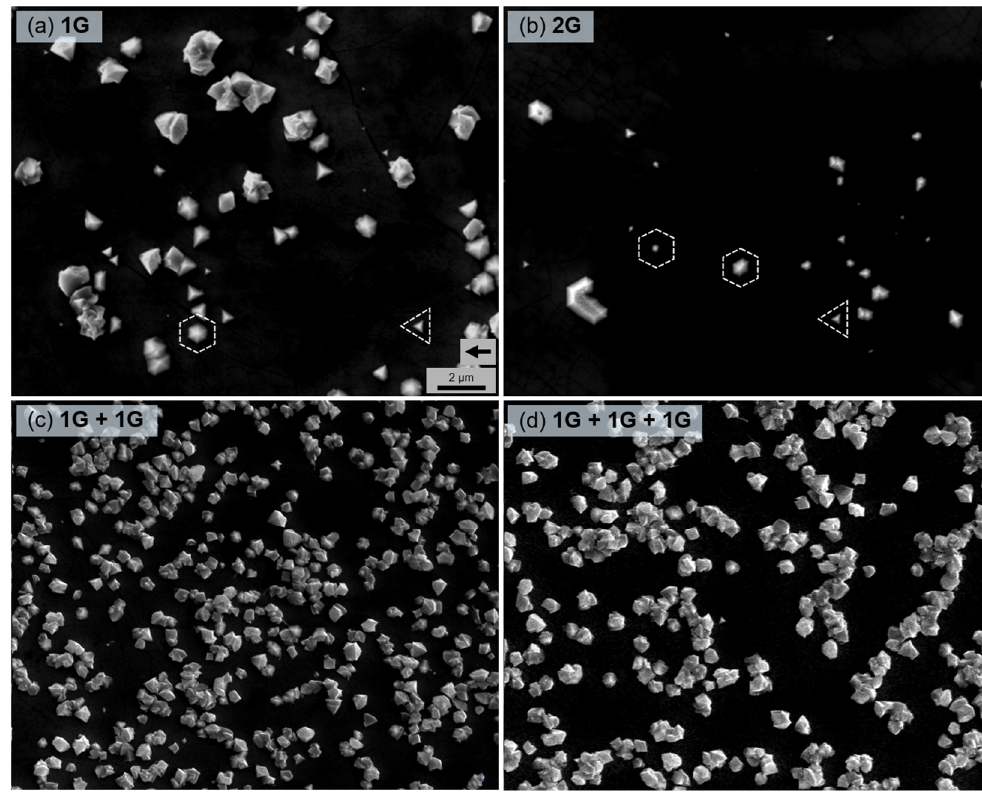
Figure 3. SEM images of the GaN nuclei after the growth of the low-temperature nucleation layer for 5 min on monolayer graphene ( a ), bilayer graphene ( b ), double-stack graphene ( c ), and triple-stack graphene ( d ). Scale bar in ( a ) is the same for all images. The black arrow in ( a ) indicates [1120] direction of an underlying sapphire substrate for all images. White dashed figures illustrate two types of GaN nuclei: hexagonal and triangular.